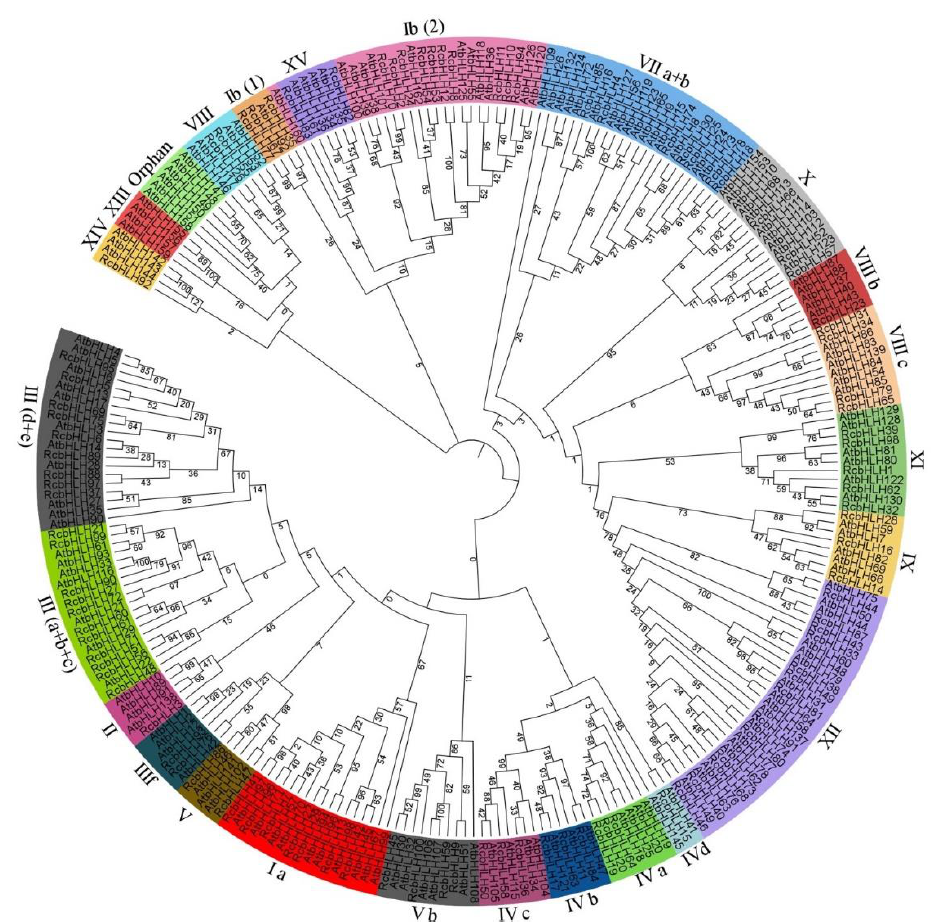
Figure 2. Phylogenetic analysis of bHLH members of rose and Arabidopsis. Different classes were denoted by different colors.